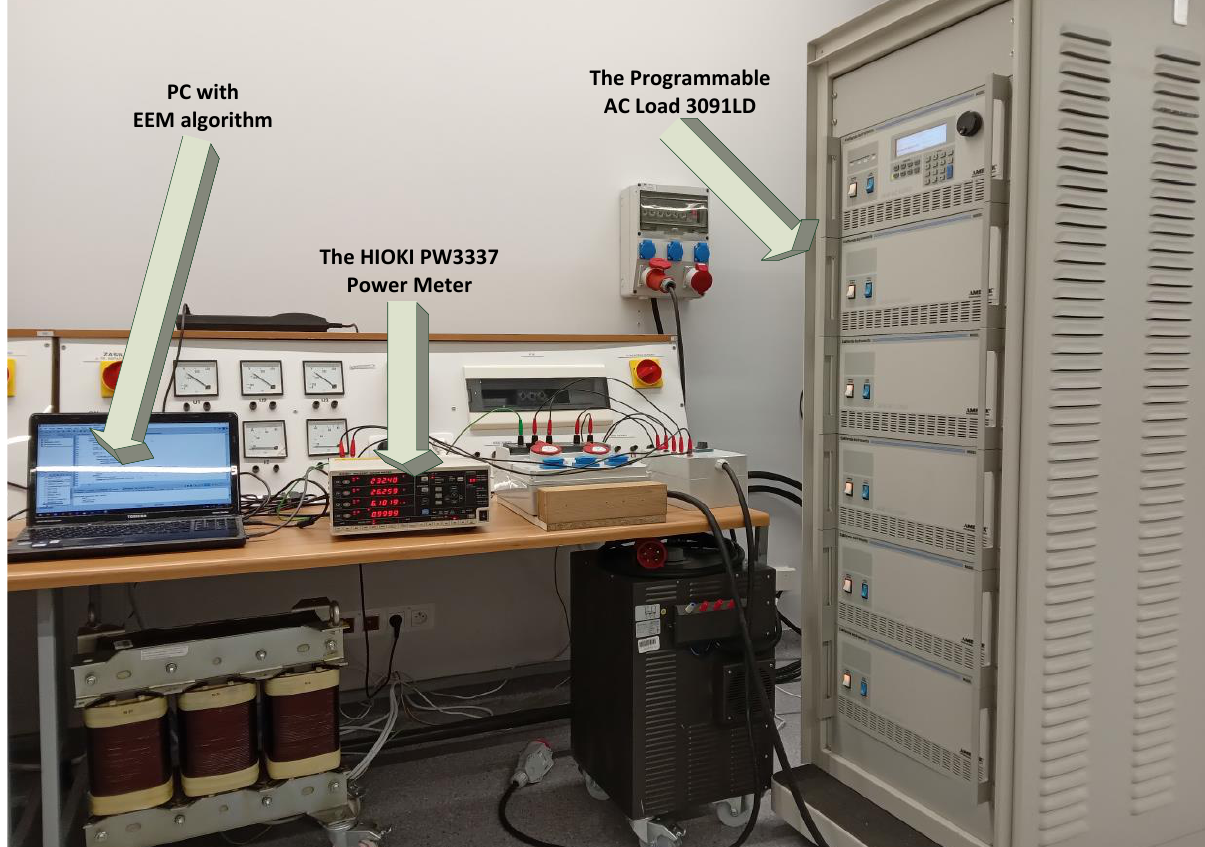
Figure 13. Photo of the laboratory experimental